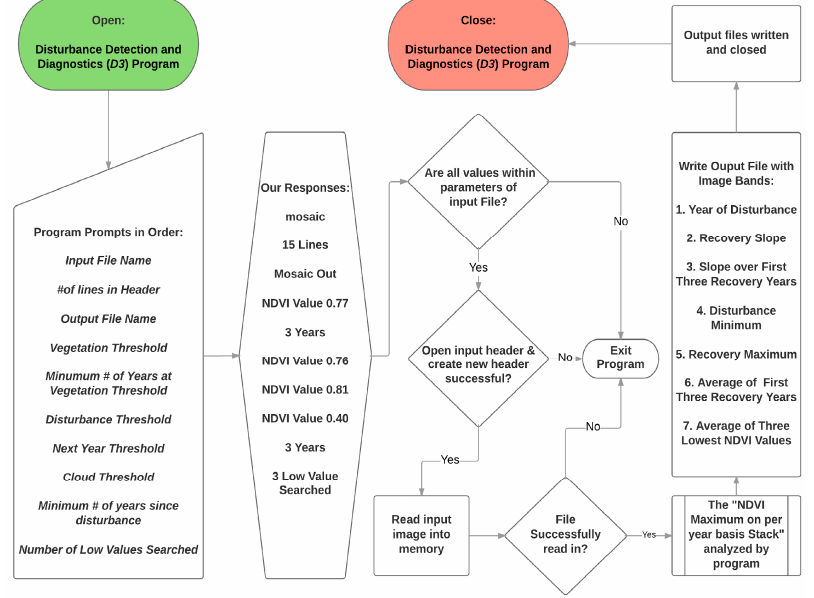
Figure A1. D 3 Program flow chart identifying program prompts and user supplied responses as an overview of the process.